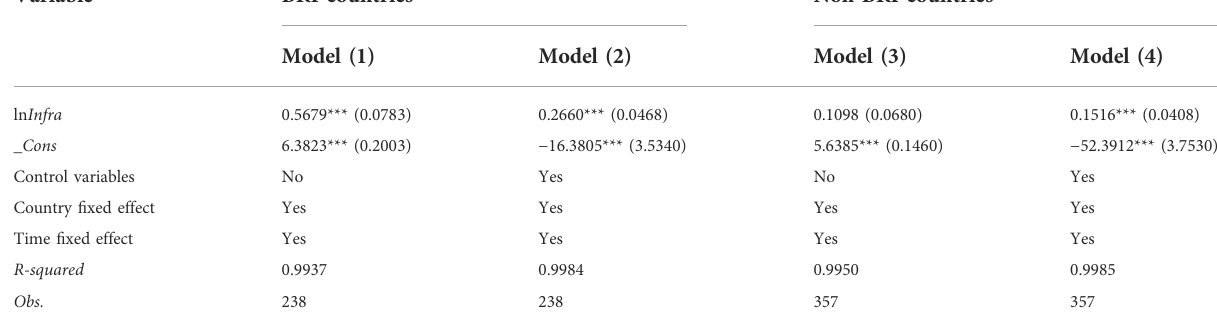
TABLE 8 Results of heterogeneous analysis.